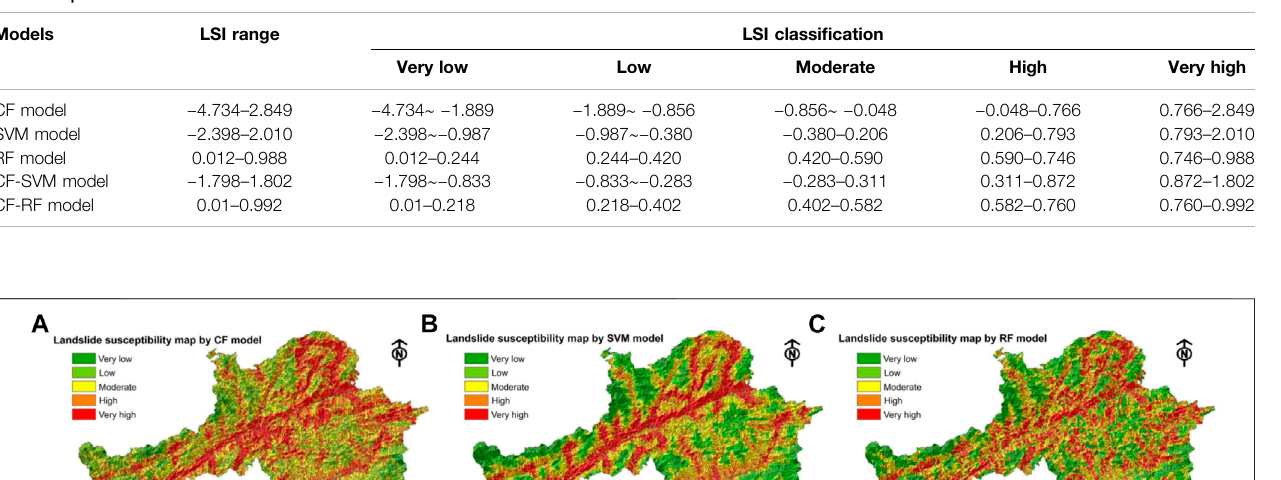
TABLE 5 | Classi fi cation of LSI for the different models.